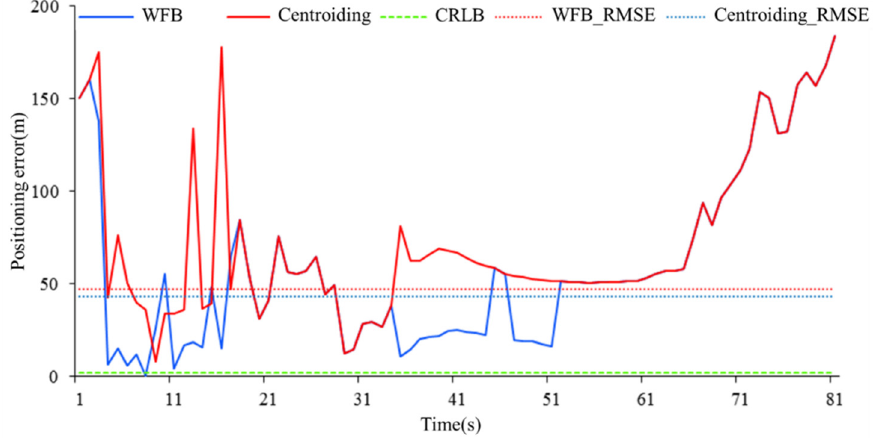
Figure 8. WFB fusion method analysis of the positioning accuracy.